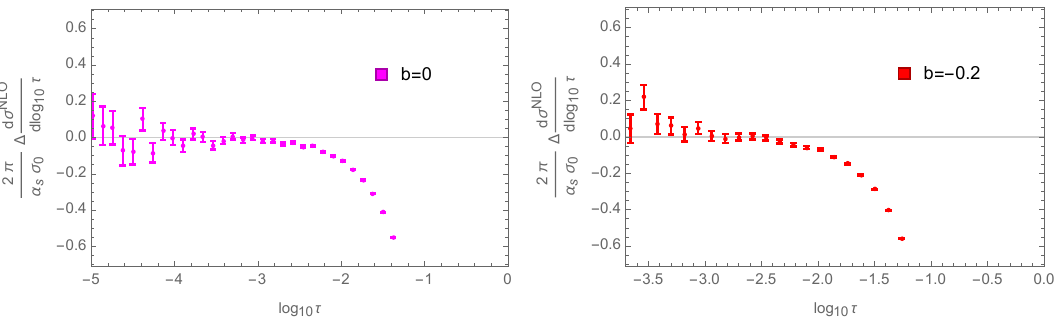
Figure 5 . Differences between Event2 and our one-loop results from SCET τ in the cases of b = 0 (jet broadening) and b = d σ/ d log 10 the runs in [25] with n f = 5, an infrared cutoff ρ = 10 − 10 and, in addition, we generated 10 11 events with values of ρ as low as 10 − 18 for b =